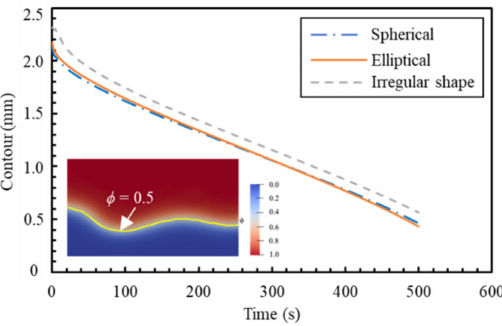
Figure 8. The contour change diagram of different particles for φ = 0.5.